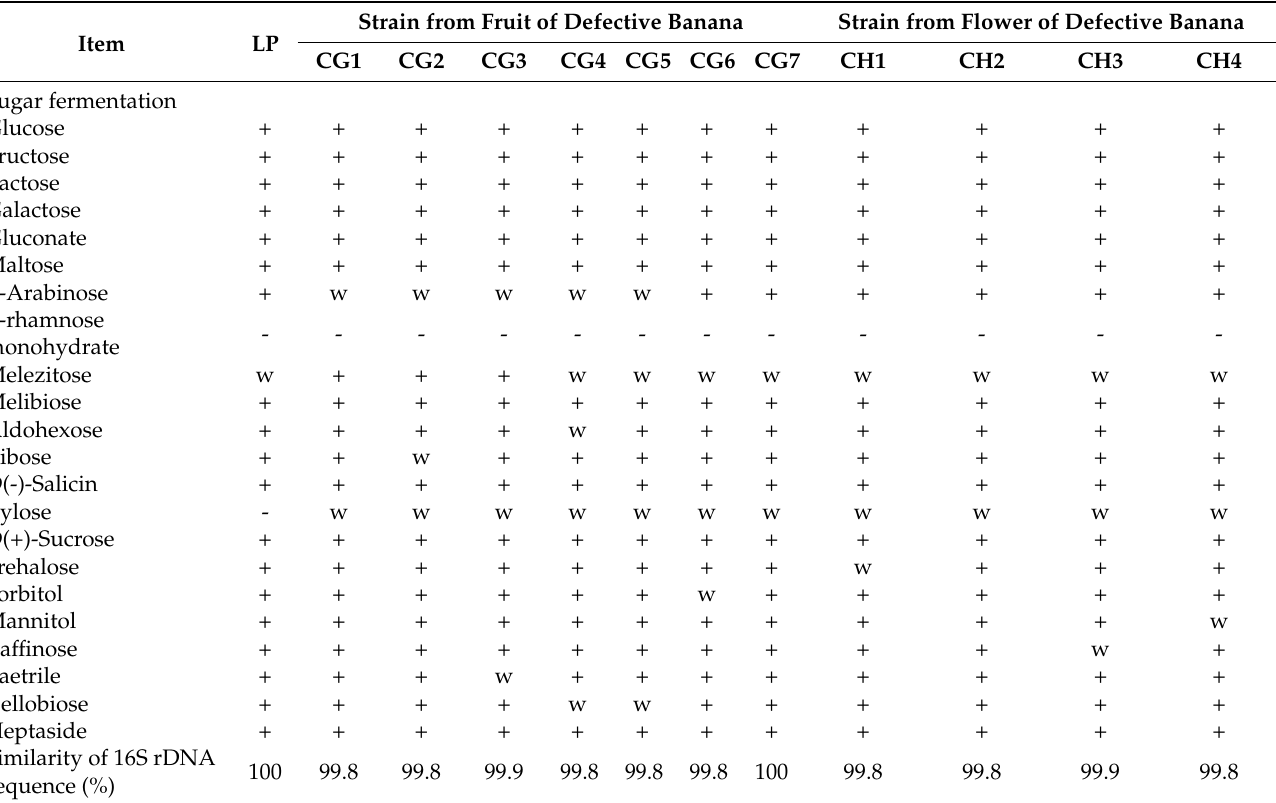
Table 2. Sugar fermentation of lactic acid bacteria and the similarity of 16S rDNA sequence between the isolate and type